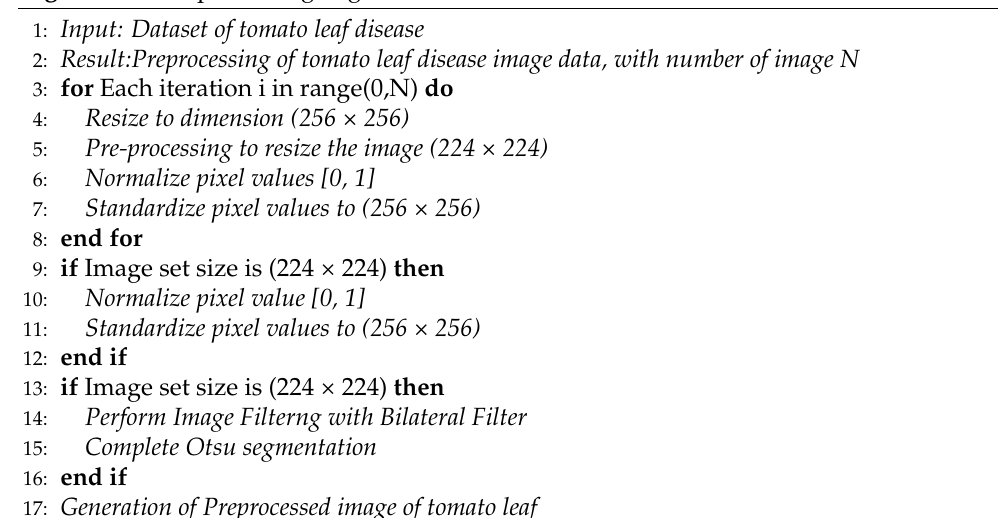
Algorithm 1 Preprocessing Algorithm for ADCLR